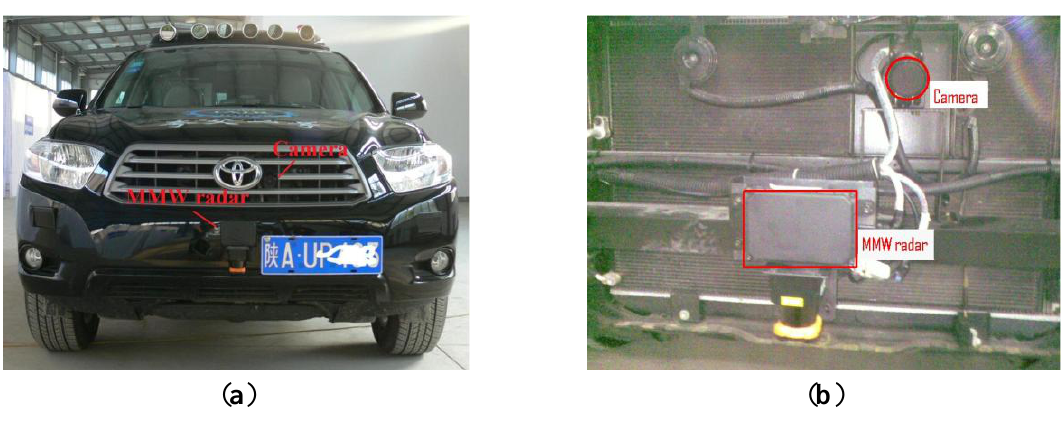
Figure 3. ( a ) The distribution of the MMW radar and CCD camera on our AGV platform; ( b ) the installation of radar and camera mounted on the